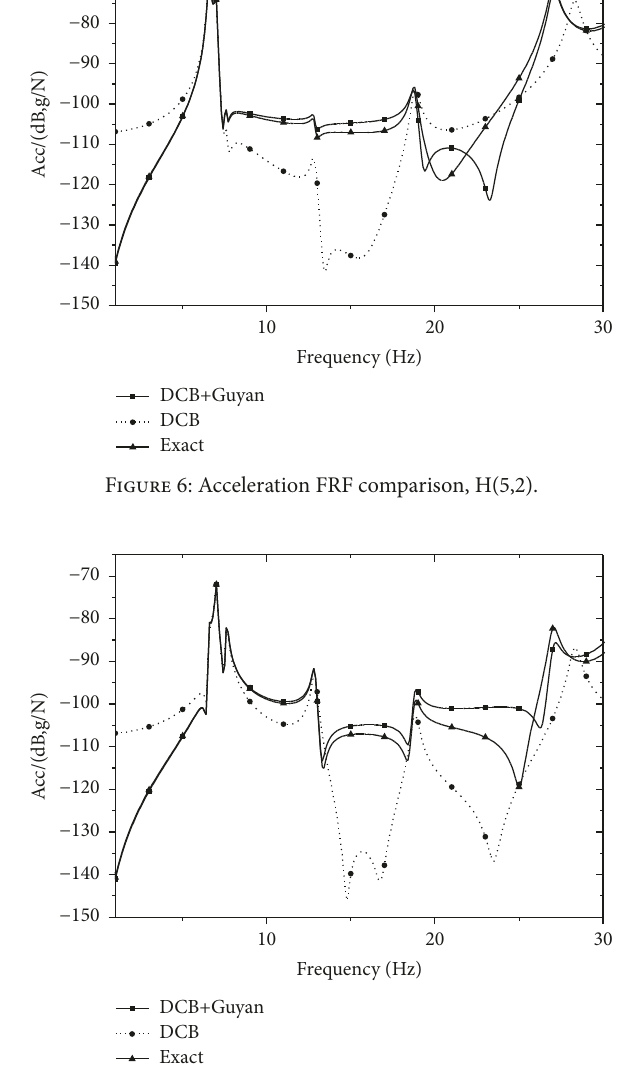
Figure 7: Acceleration FRF comparison, H(6,4).